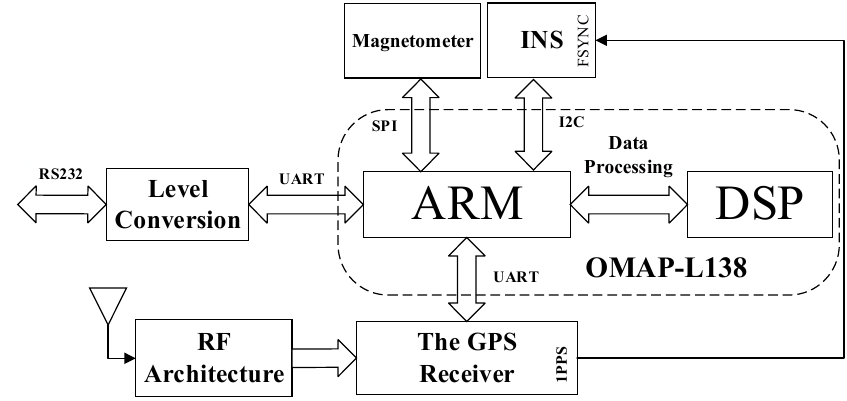
Figure 5. The architecture of the proposed system platform.